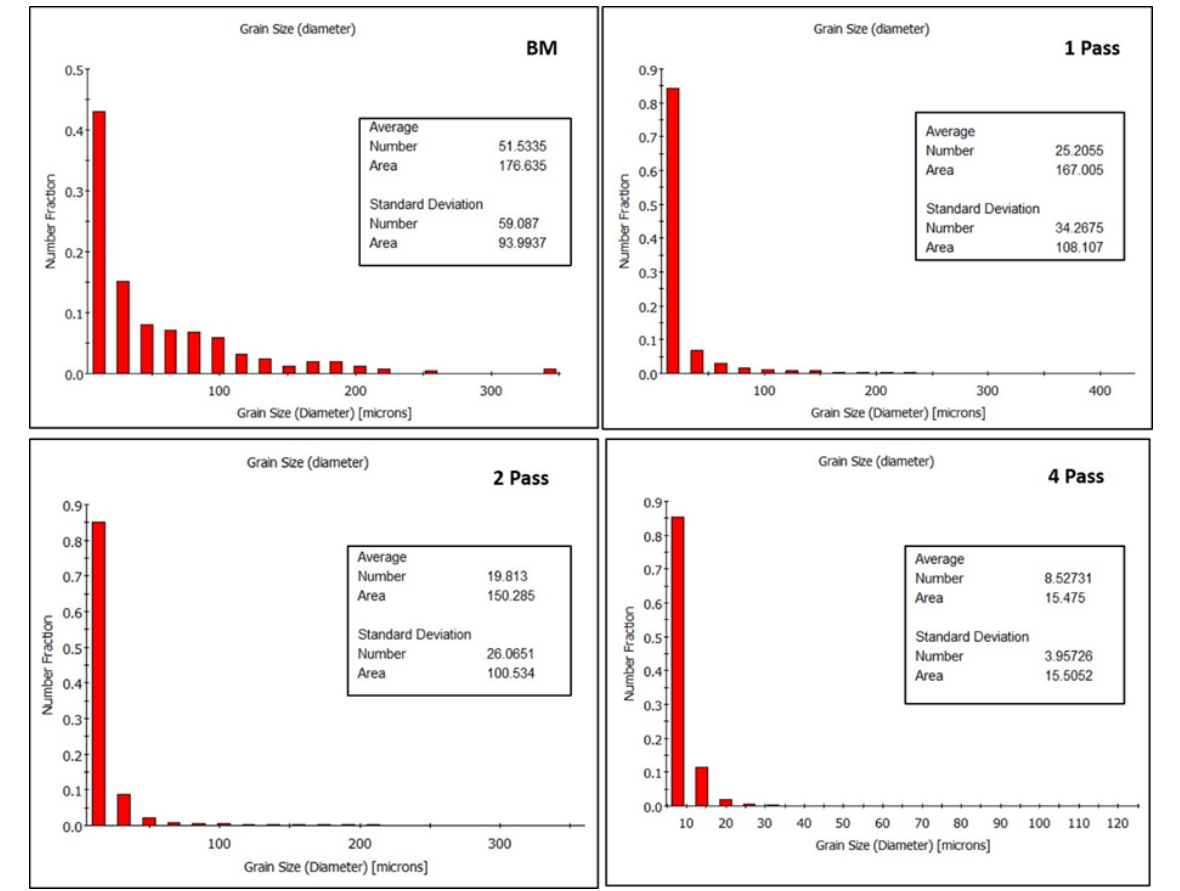
Figure 12. Grain size distribution calculated from the EBSD data presented in Figure 10 for the AA2011 BM after ECAP processing for different passes.